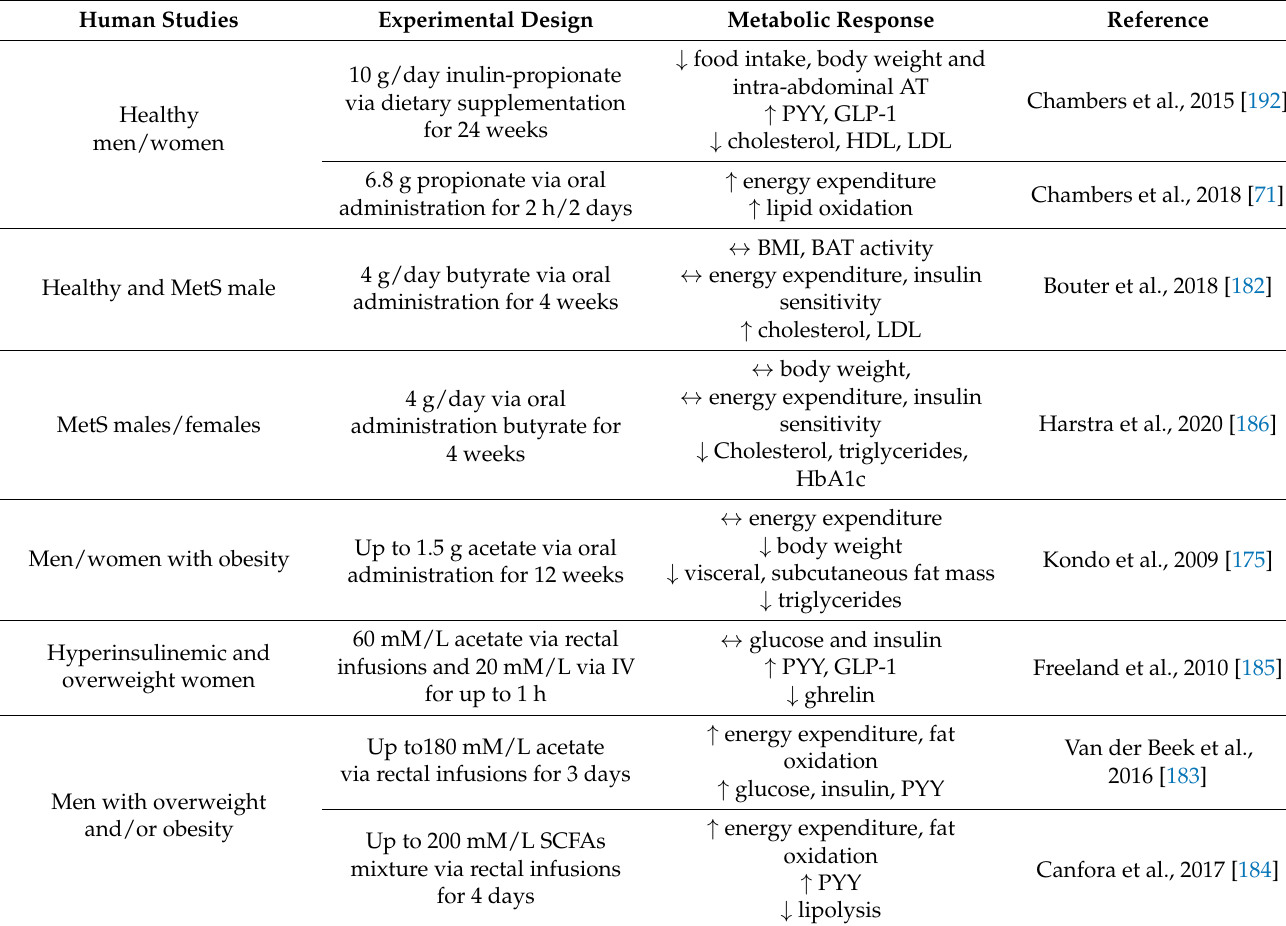
Table 5. Routes of administration of SCFAs to impact adipose tissue metabolism in